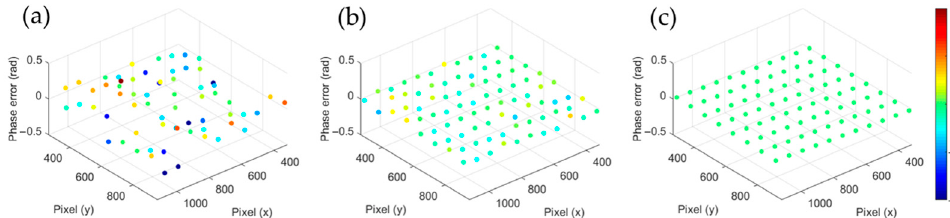
Figure 3. Experiment of phase error suppression at checkerboard corners. ( a ) The phase error of sub-pixel corners extracted by bilinear interpolation, ( b ) by fitting the phase of the local white squares directly, and ( c ) by fitting the phase of the local white squares with RANSAC.